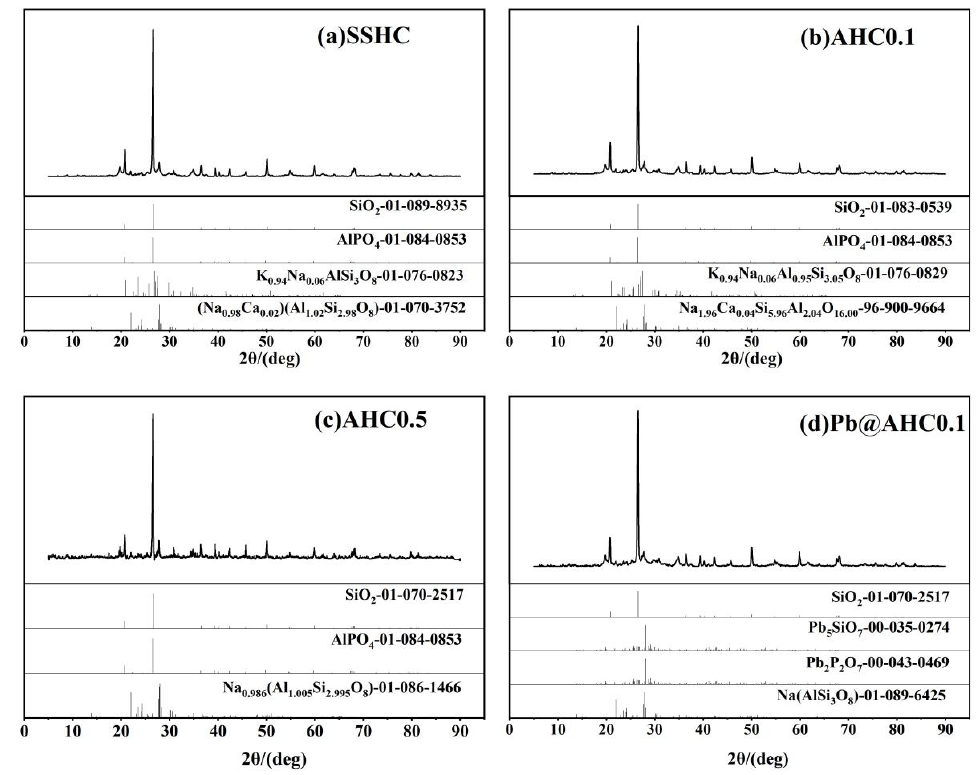
Figure 5. XRD patterns of SS-derived hydrochars and Pb@AHC0.1.